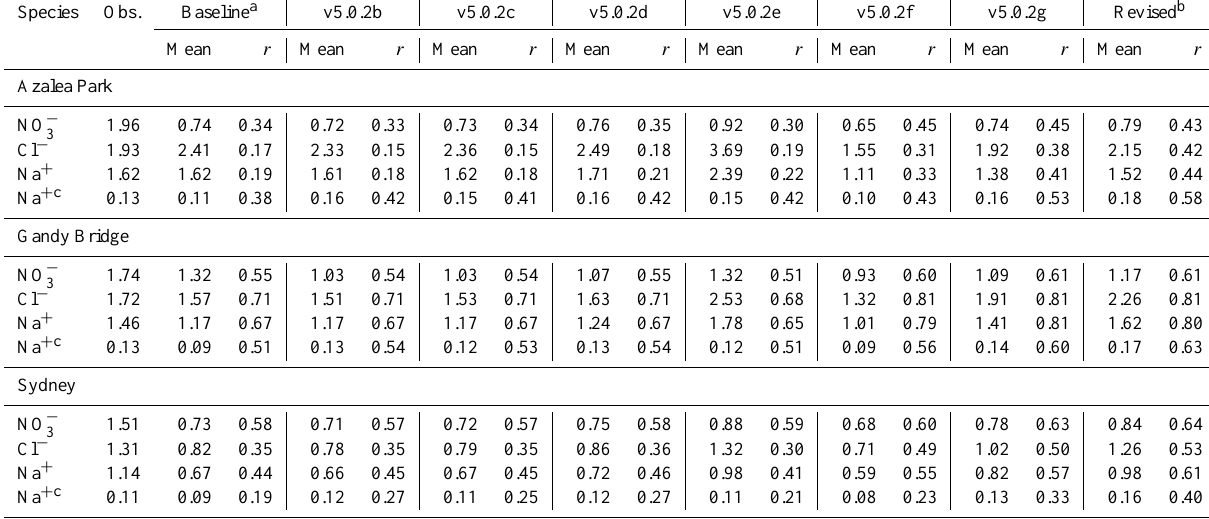
Table 2. Comparison of the mean and Pearson’s correlation coefficient ( r ) of total observed and model-predicted inorganic particle concen- trations (µgm − 3 ) at three Bay Regional Atmospheric Chemistry Experiment (BRACE) sites near Tampa,